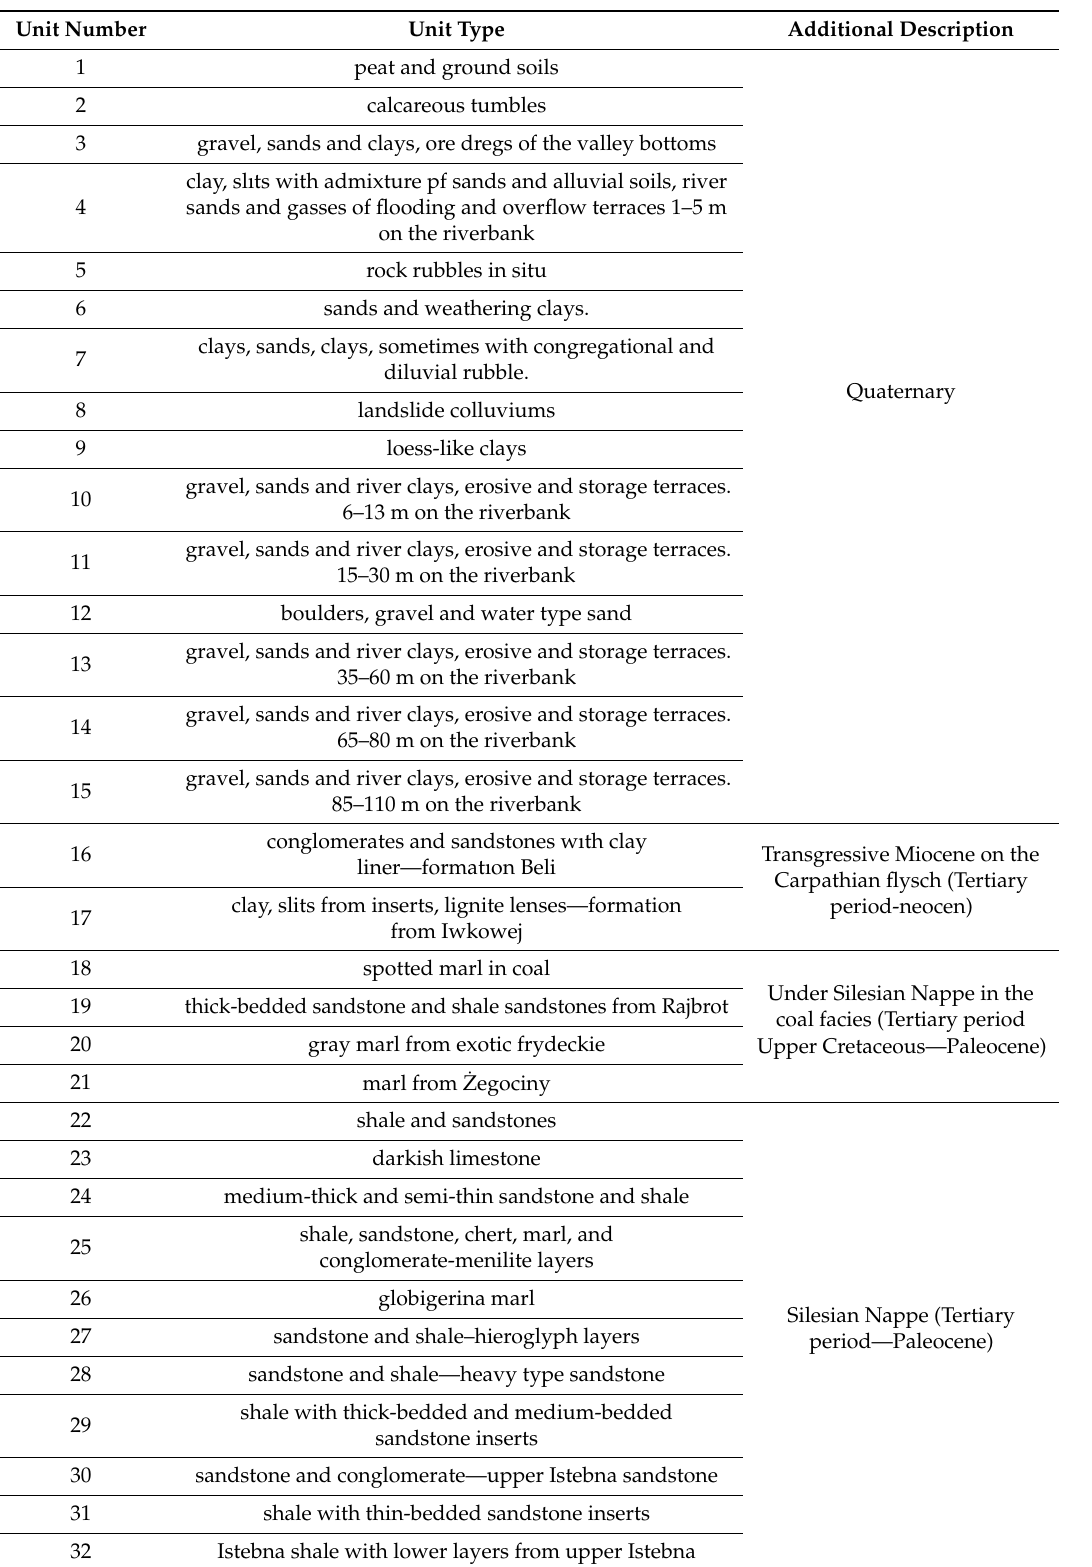
Table A1. Explanation to geological units presented in Appendix